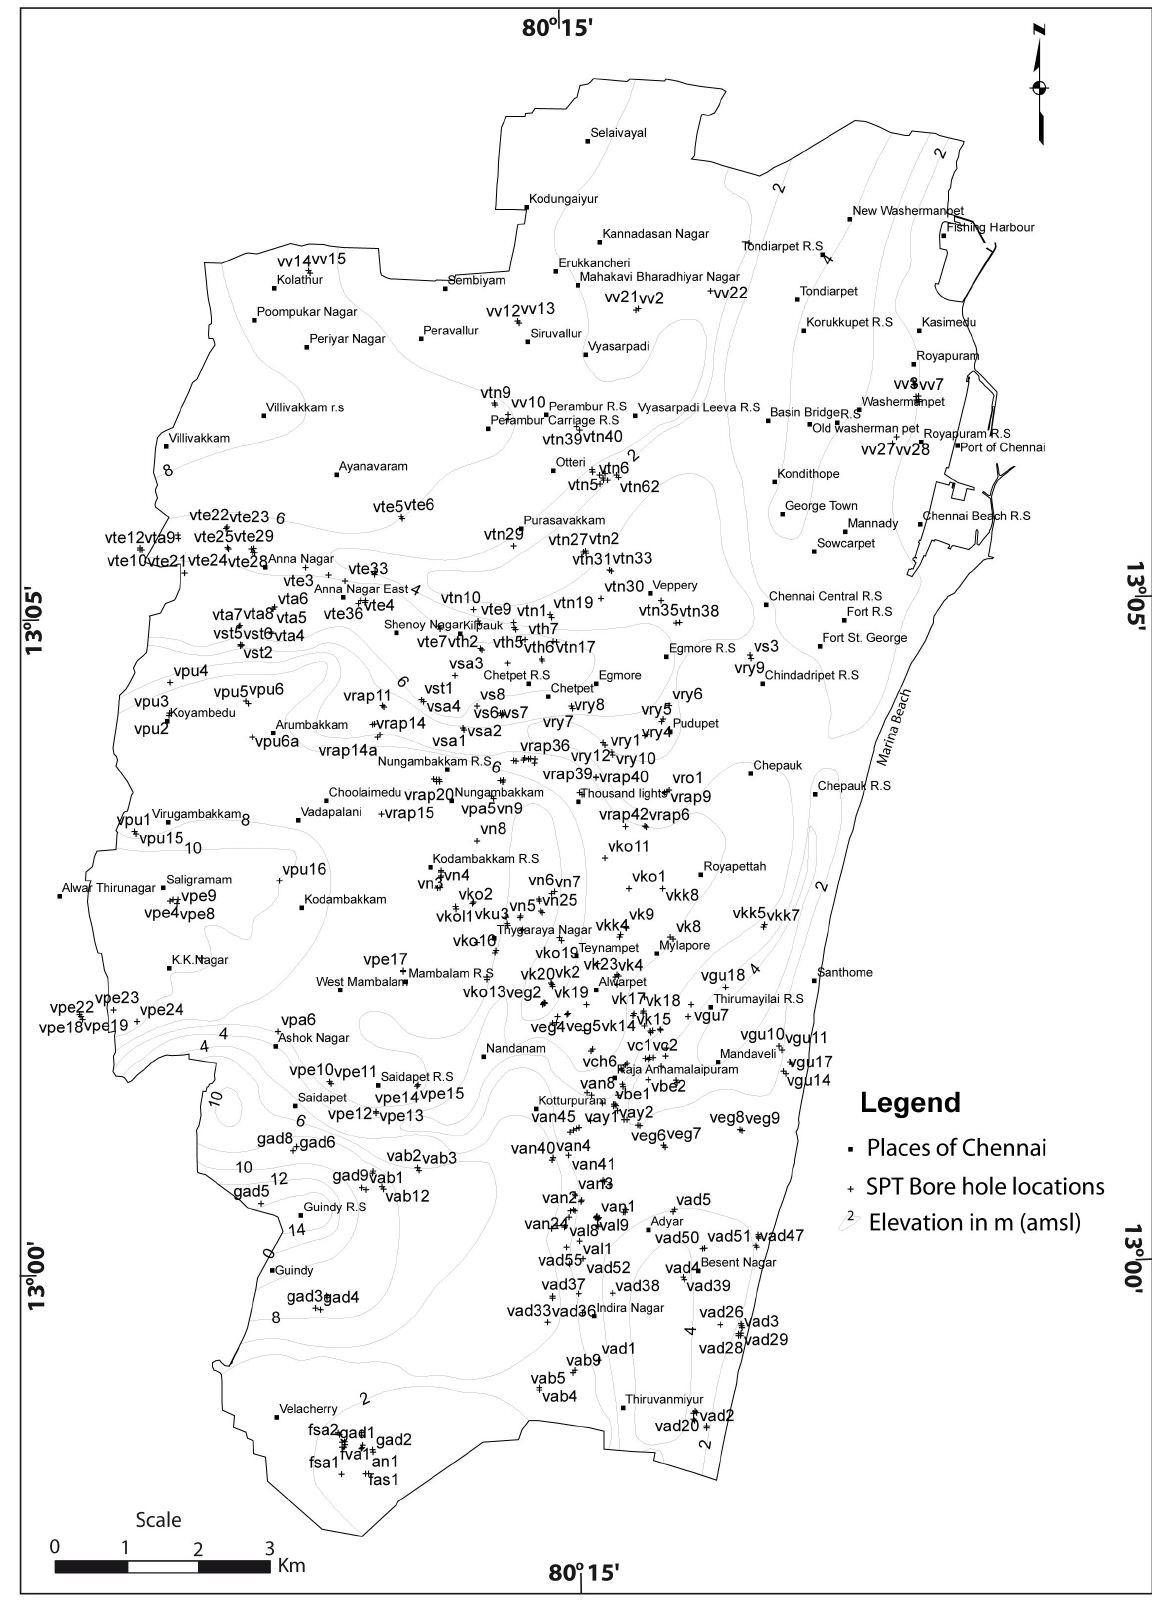
Fig. 3. Location of boreholes used for the geotechnical